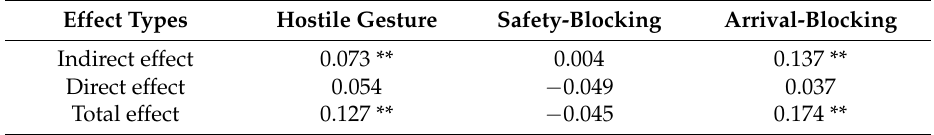
Table 4. The standardized direct, indirect, and total effects of each type of driving anger on crash